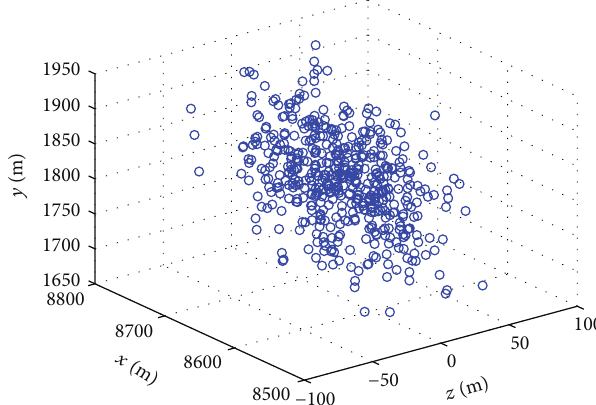
Figure 12: The distribution of target acquisition points.